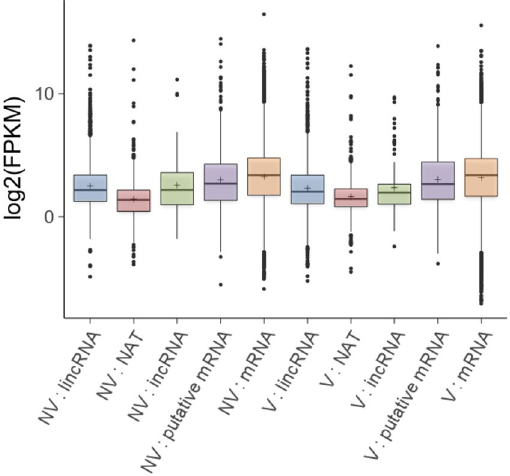
Figure 2. Boxplot for the expression of lincRNA, NAT, incRNA, putative mRNA, and mRNA classified transcripts prior to cold treatment (NV) and after 4 weeks of cold treatment (V). Plus ( + ) symbol is the mean log2 (FPKM) expression for the respective